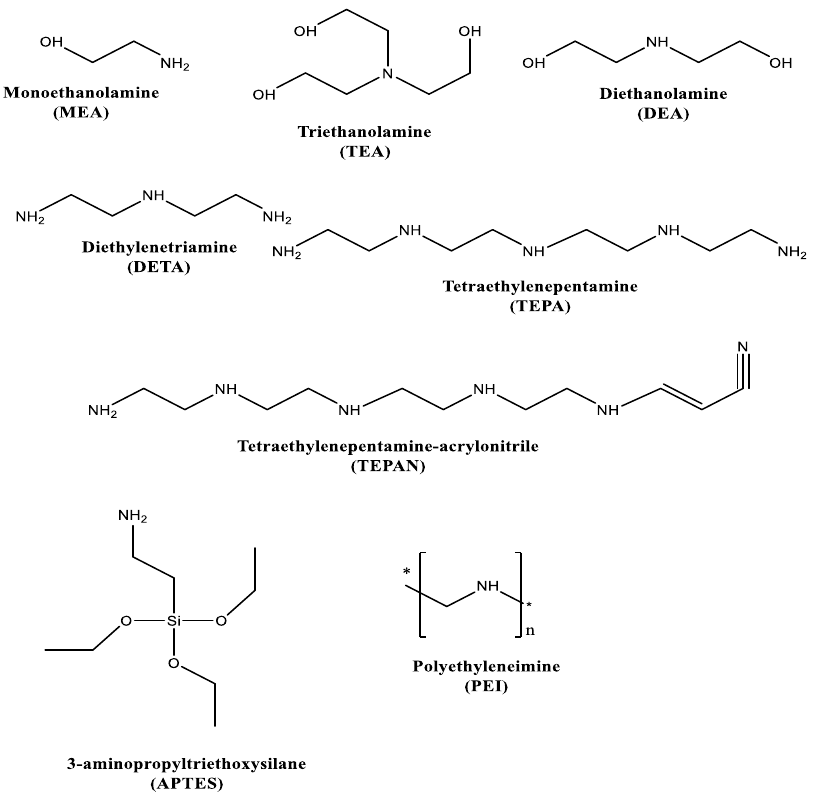
Figure 4. Common amine adsorbents.